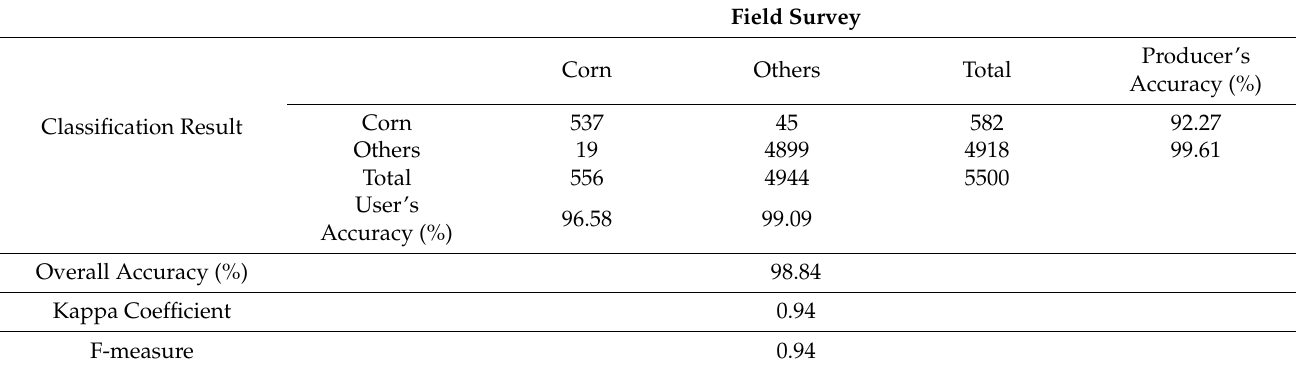
Table 6. Error matrix for evaluating the accuracy of the Farm Map-based RF algorithm.